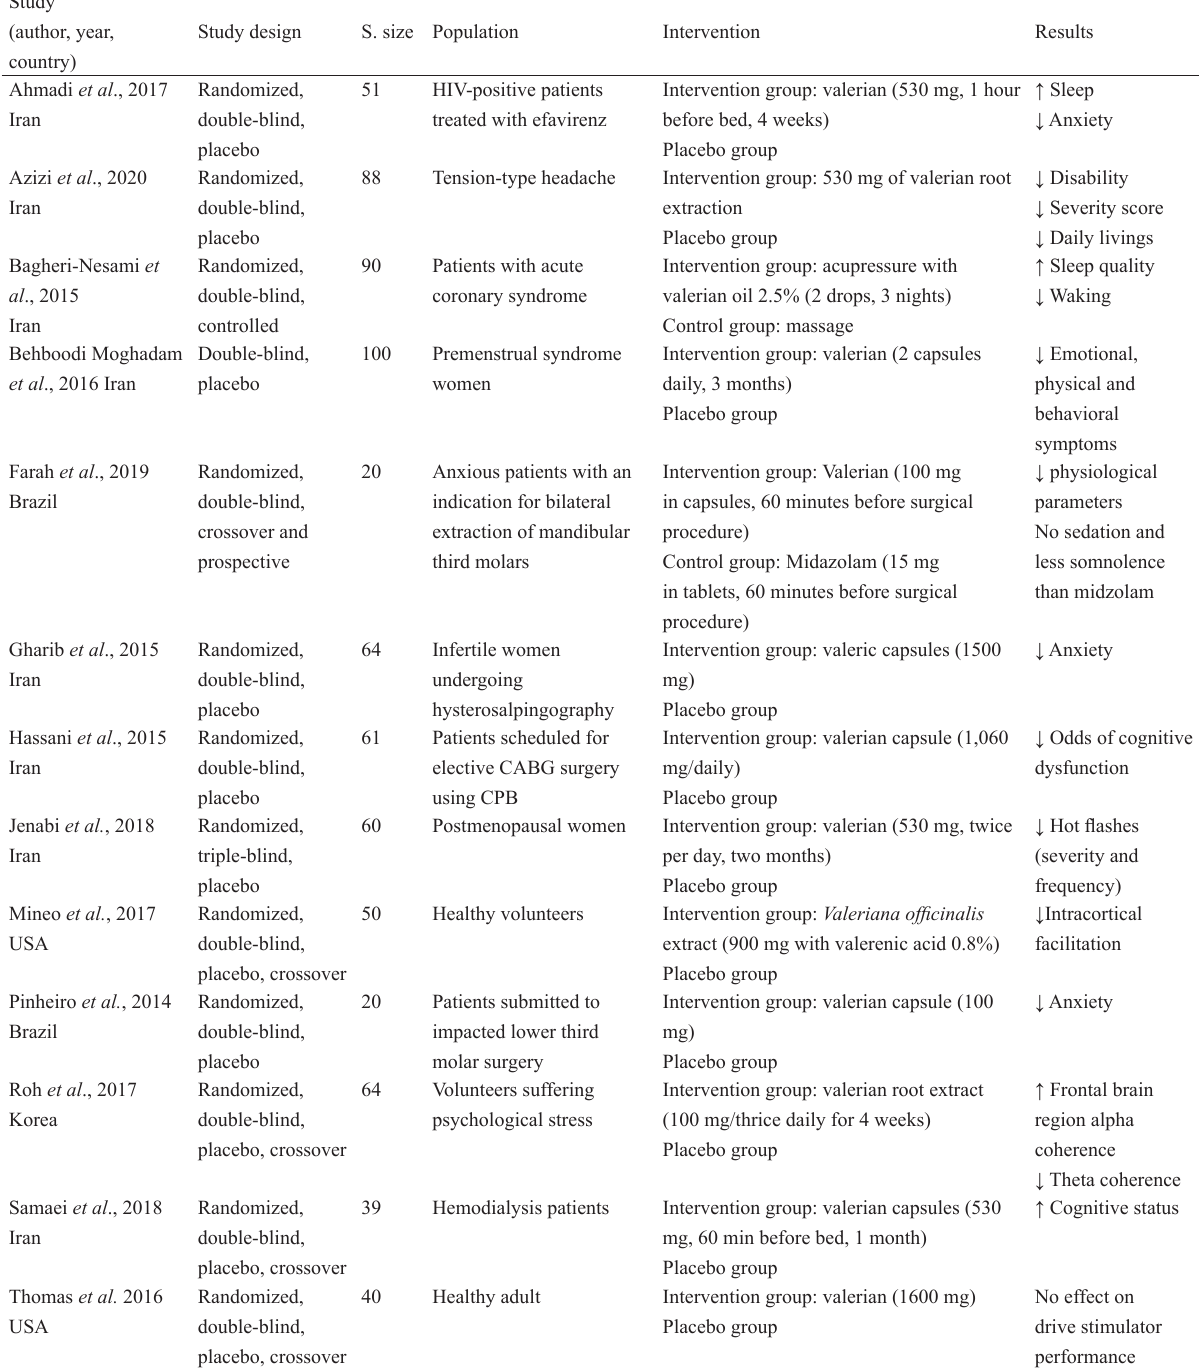
Table 3. Clinical trials for Valeriana officinalis . Abbreviations are: S. size, sample